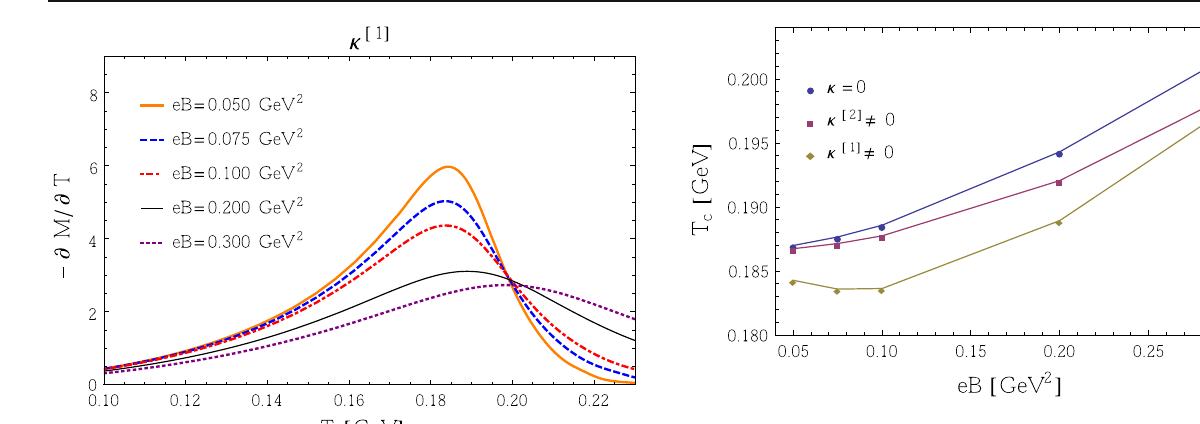
eB (cid:4) 0 . 05 GeV 2 , and are always bigger than the ones with κ [ 2 ] and κ = 0 in the strong magnetic field regime. In our evaluations, there are no oscillations in the effective quark masses, as observed in several evaluations in the κ = 0 [53] or with κ (cid:13)= 0 [37,39,40,43]. These nonphysical oscillations observed in the literature for the constituent quark mass, pseudocritical temperature for chiral symmetry